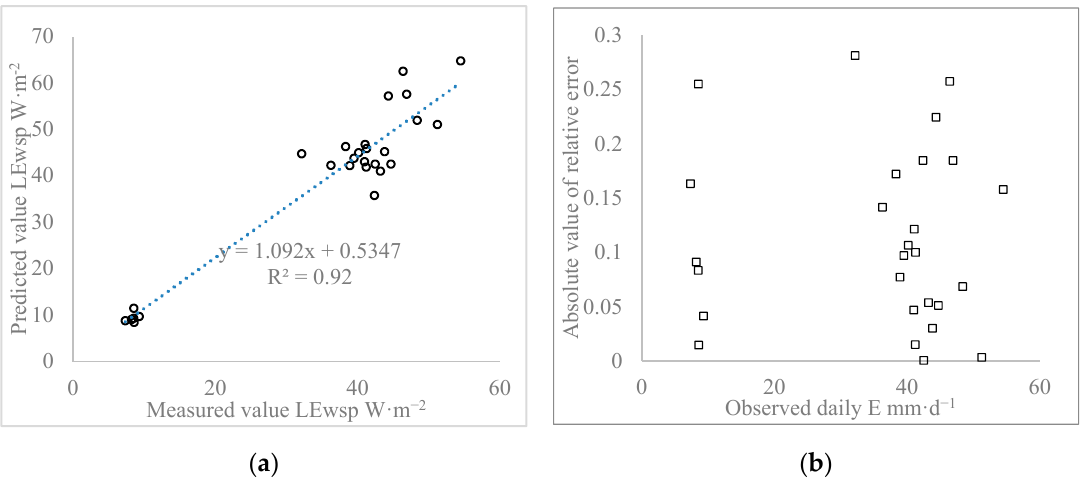
Figure 5. ( a ) The linear relationship between the predicted and measured values of 𝐿𝐸 (cid:3046) ; ( b ) The linear relationship between the predicted and measured values of 𝐿𝐸 (cid:3043) 4. Discussion 4.1. Comparison of different soil resistance models underWSPI The calculation of soil surface resistance is generally based on an empirical formula, a semi- empirical formula, or the perspective of physics. Some of the most common formulas with high precision can be found in Table 5. Table 5. The types and sources of Soil surface resistance models. model